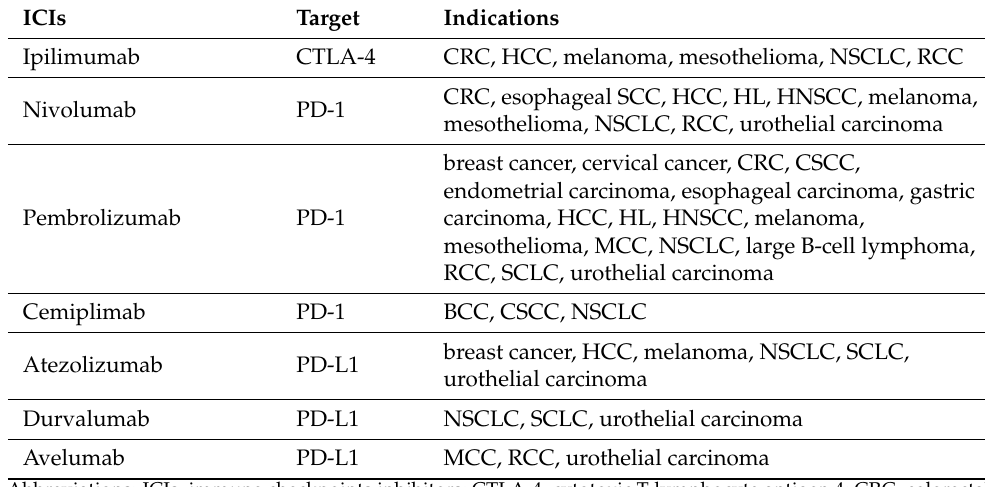
Table 1. Summary of immune checkpoint inhibitors approved by the Food and Drug